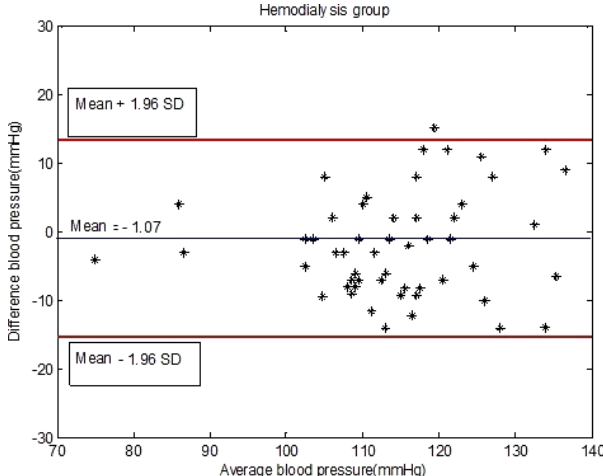
Fig. 8. Bland – Altman plots demonstrating the overall agree- ment between the BP cuff and the calculated BP as a linear function of PTT in all eight sets of data by using each patient's individual linear function